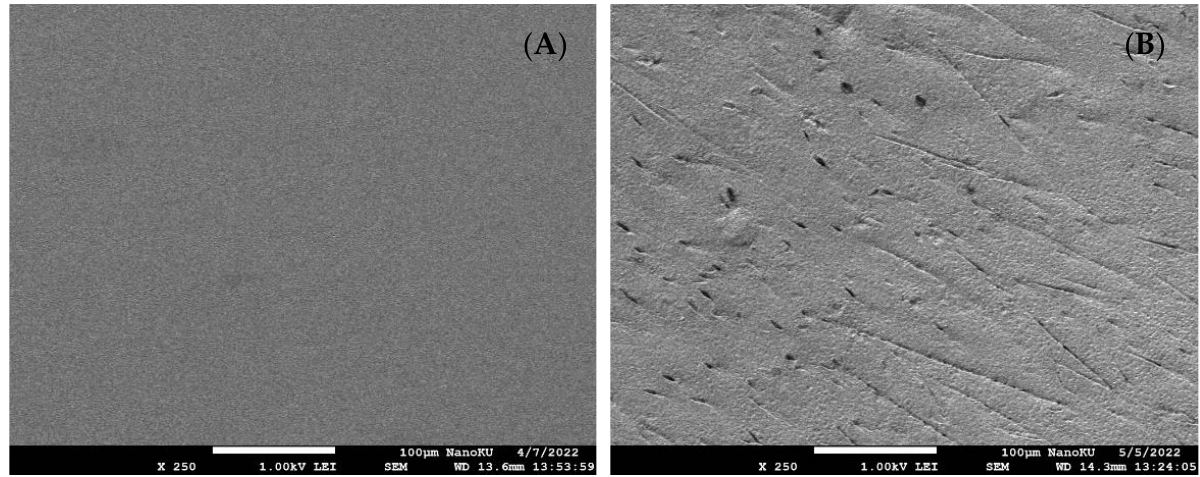
Figure 5. Surface morphology of mulching film (40PVA/60LN): ( A ) before; and ( B ) after 24 h of water solubility.